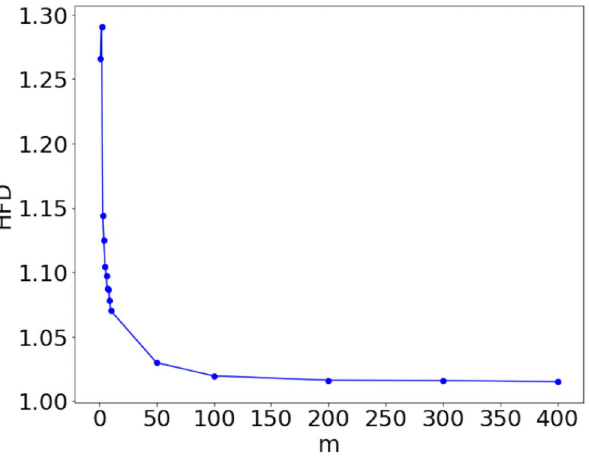
Fig 8. HFD of BA ensemble potentials. Higuchi fractal dimension (HFD) of the ensemble potential V graphs with N = 500 nodes, resulting from a BA model, as a function of the parameter m .